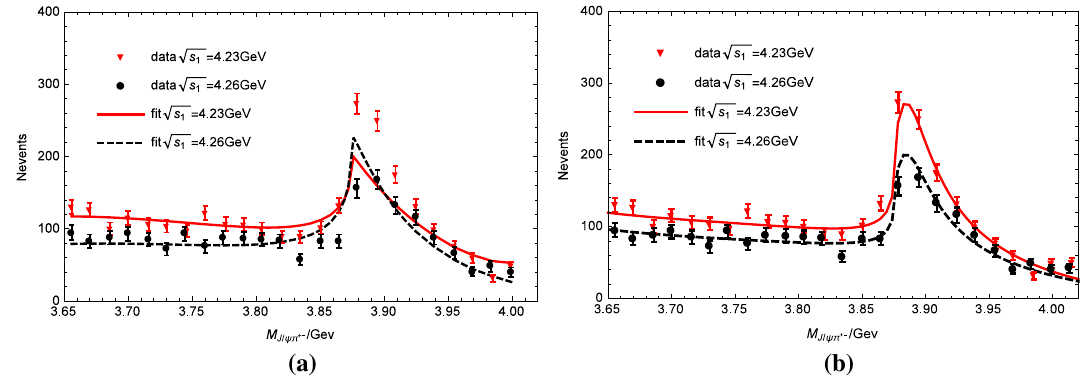
√ √ Fig. 10 Simultaneous fit to data at s 1 = 4 . 23 GeV and data at s 1 = 4 . 26 GeV. The integrated luminosity of these two data sets are renormalized to be equal. a Fit I’, triangle diagram; b Fit II’, bubble chains. Data are from Refs. [23,24]